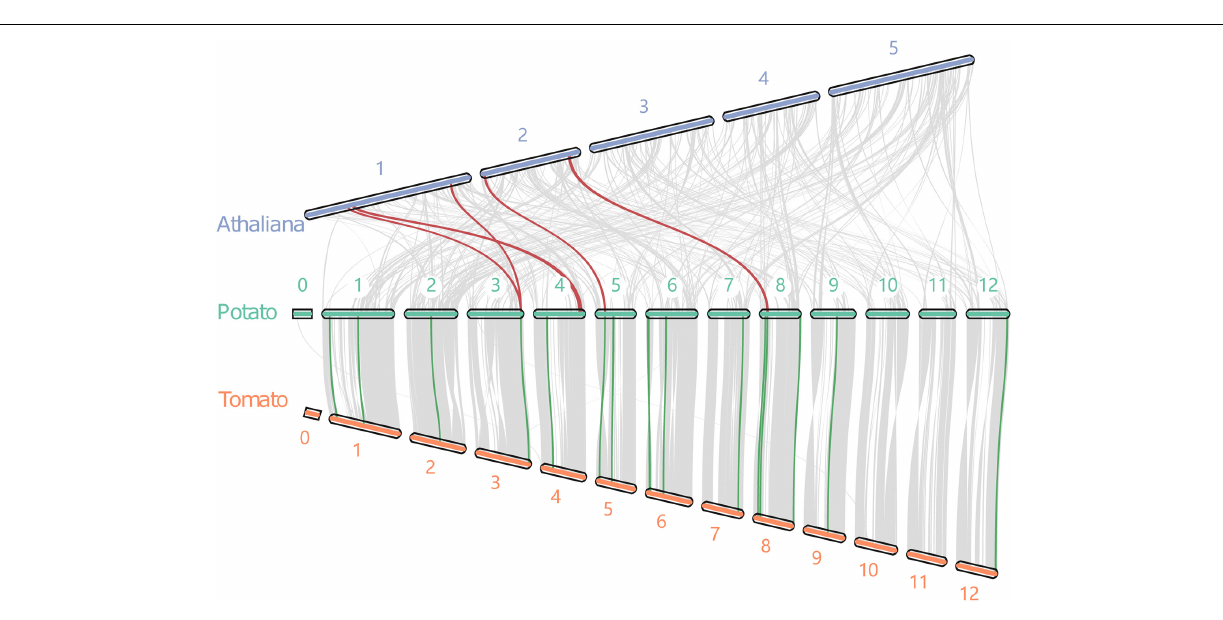
potato to be more closely related to the tomato (Xu et al.,